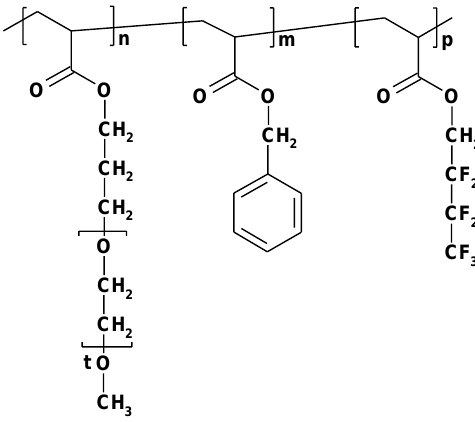
Figure 6. Chemical structure of the ABC triblock terpolymer POEGA-PBzA-PFA. Noolandi, J.; Hong, K.M. Theory of block copolymer micelles in solution. Macromolecules 1983 , 16 , 1443–1448.